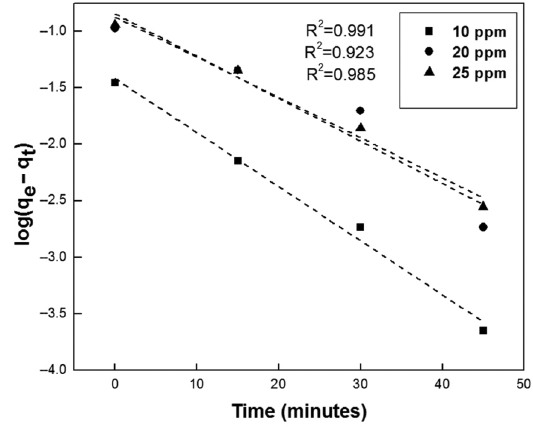
Figure 5. log( q e – q t ) against time plot at different initial concentrations Table 2. Lagergren pseudo- first order rate constants for adsorption of MB dye on PVC-Fe-ZnO nanocomposite Initial con- cent ration, mg/L Figure 6. Two stage time-concentration profiles of dark and photo reactions with varying initial concentration of